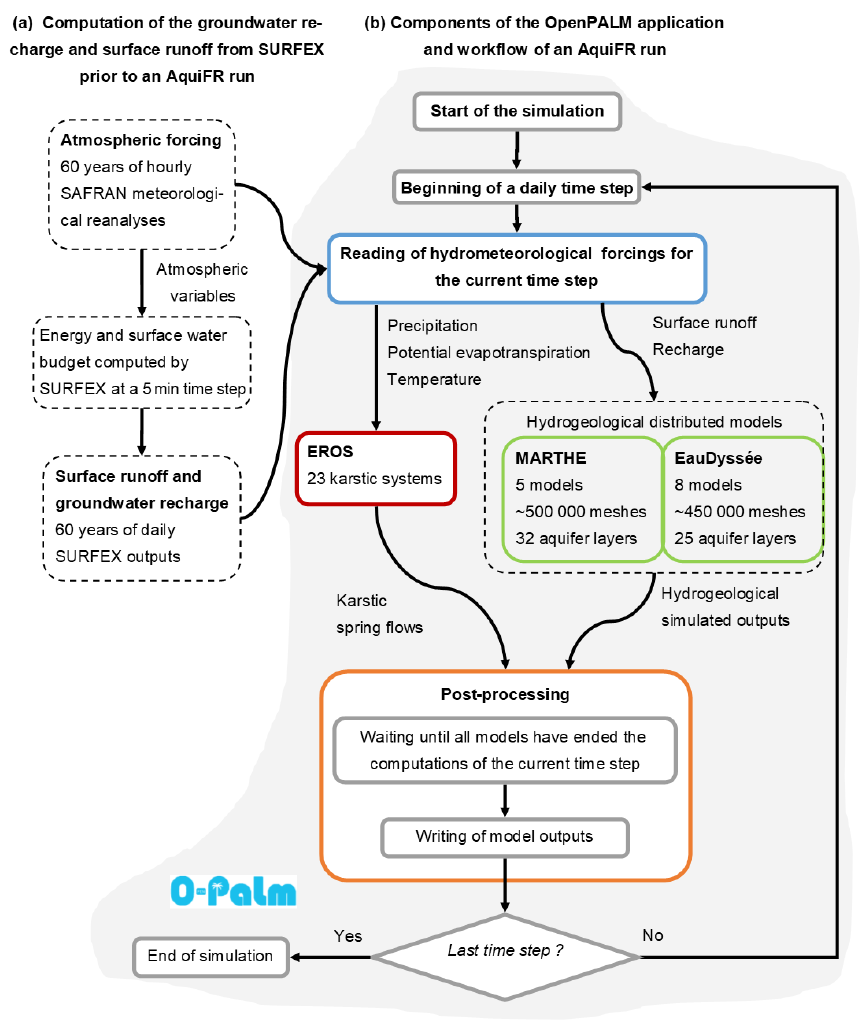
Figure 2. Scheme of the numerical implementation of AquiFR. (a) SAFRAN and SURFEX are run separately, as well as the processes that extract the daily surface runoff and groundwater recharge at 8km resolution on a daily time step over the full 60-year period. (b) The components implemented within the OpenPALM (O-Palm) coupling system are presented. Pre-processing in blue gives access to the surface runoff and groundwater recharge as well as atmospheric forcing to the three groundwater models for the current time steps. Then, each hydrogeologic software programme runs all of their models for the current time step. The fluxes and state variables are then transferred daily to post-processing that writes the model outputs and manages the following time